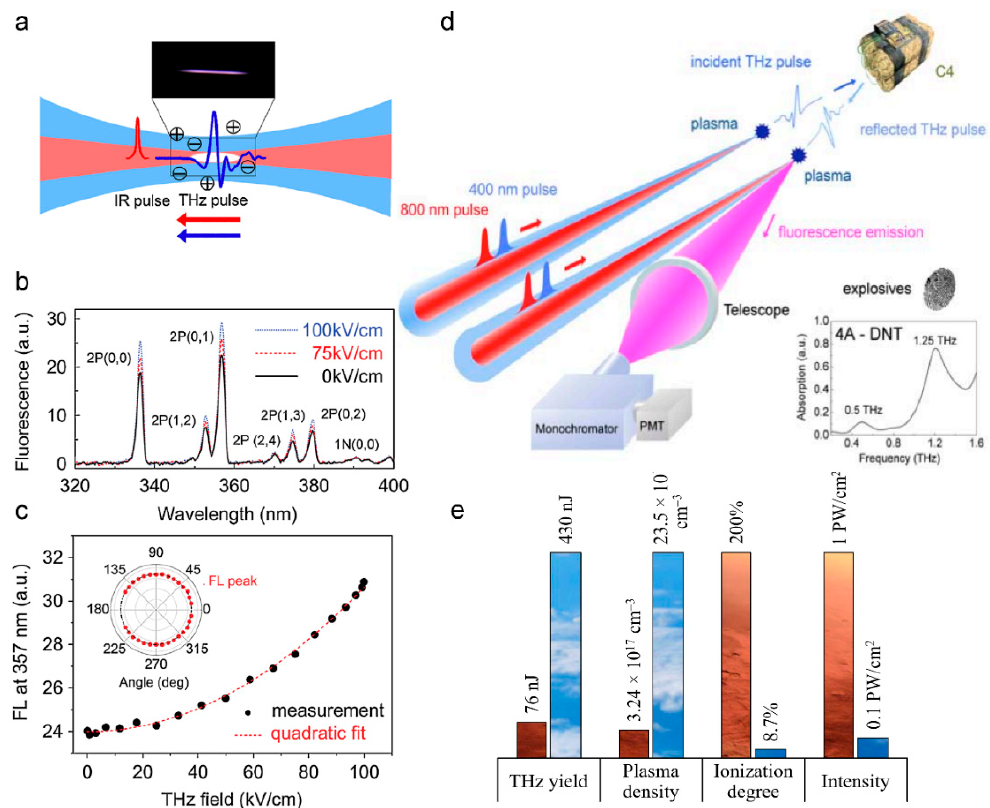
Figure 13. Filamentation-assisted terahertz remote sensing. ( a ) Schematics of the interaction between the THz wave and laser-induced plasma. ( b ) Measured fluorescence spectra versus the THz field at t d = -1 ps. Major fluorescence lines are labeled. t d : time delay between the THz pulse peak and the laser pulse peak. ( c ) Measured quadratic THz field dependence of 357 nm fluorescence emission line at t d = -1 ps. Inset: the isotropic emission pattern of THz-REEF [204]. ( d ) Envisioned scheme for THz stand-off generation and detection. There are two dual-color pulses that are focused close to the target under investigation creating a plasma emitter and a plasma sensor. For this figure, the absorbance spectrum of the target is retrieved through THz-REEF [209]. ( e ) The comparison of THz yield and femtosecond optical breakdown parameters in the atmosphere of Mars and Earth [210].